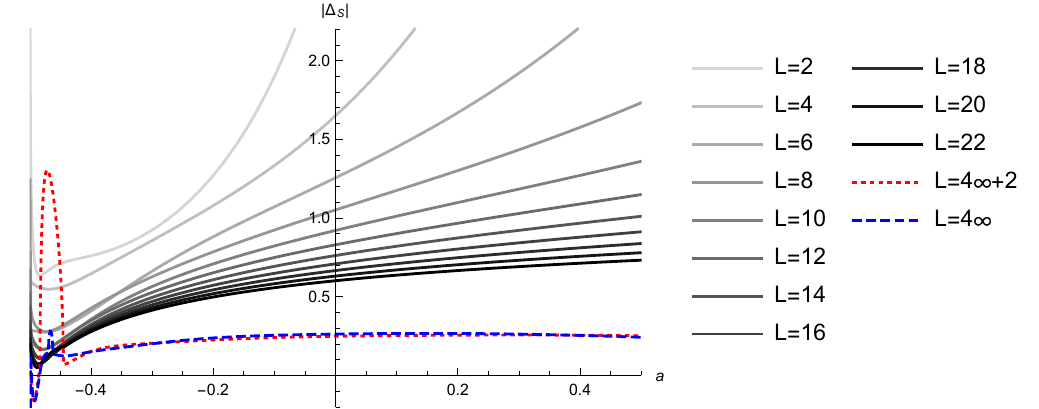
Figure 7 . Plots of | ∆ S | (2.21) for the “double brane” solution Φ D horizontal axis denotes the value of the parameter a